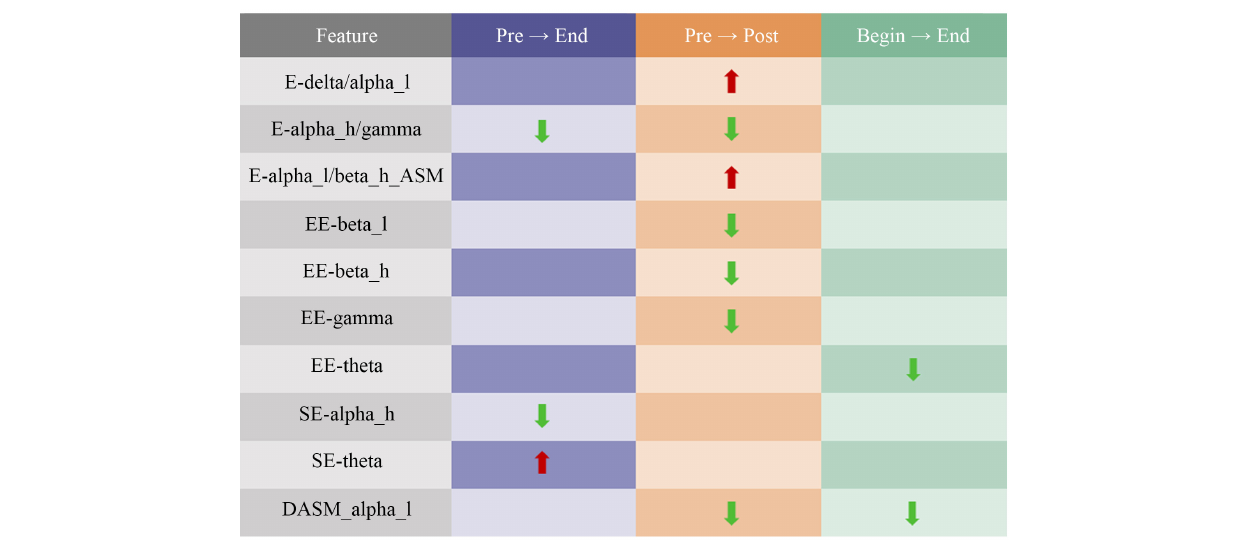
between the predicted value and the true value. The formula is illustrated below, where n indicates the number of the EEG data, y i is the true value, and b y i is the predicted value. The lower the value, the better is the training